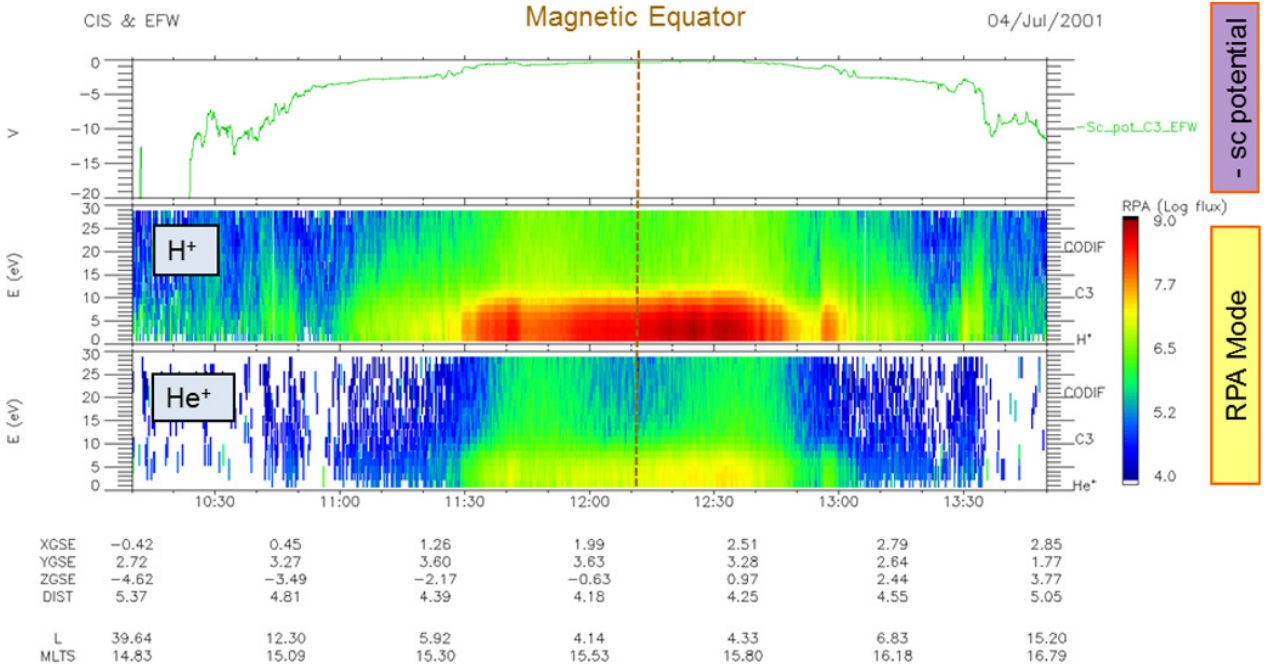
Fig. 7. Cluster C3 data for the 4 July 2001 event. From top to bottom: negative of the spacecraft potential measured by the EFW experiment, which is a proxy of changes in the plasma density; CODIF omnidirectional H + and He + energy–time spectrograms in particle flux units (cm − 2 s − 1 sr − 1 keV − 1 ) in the RPA mode (low-energy ions detection); spacecraft coordinates in the GSE system; L parameter and spacecraft magnetic local time.